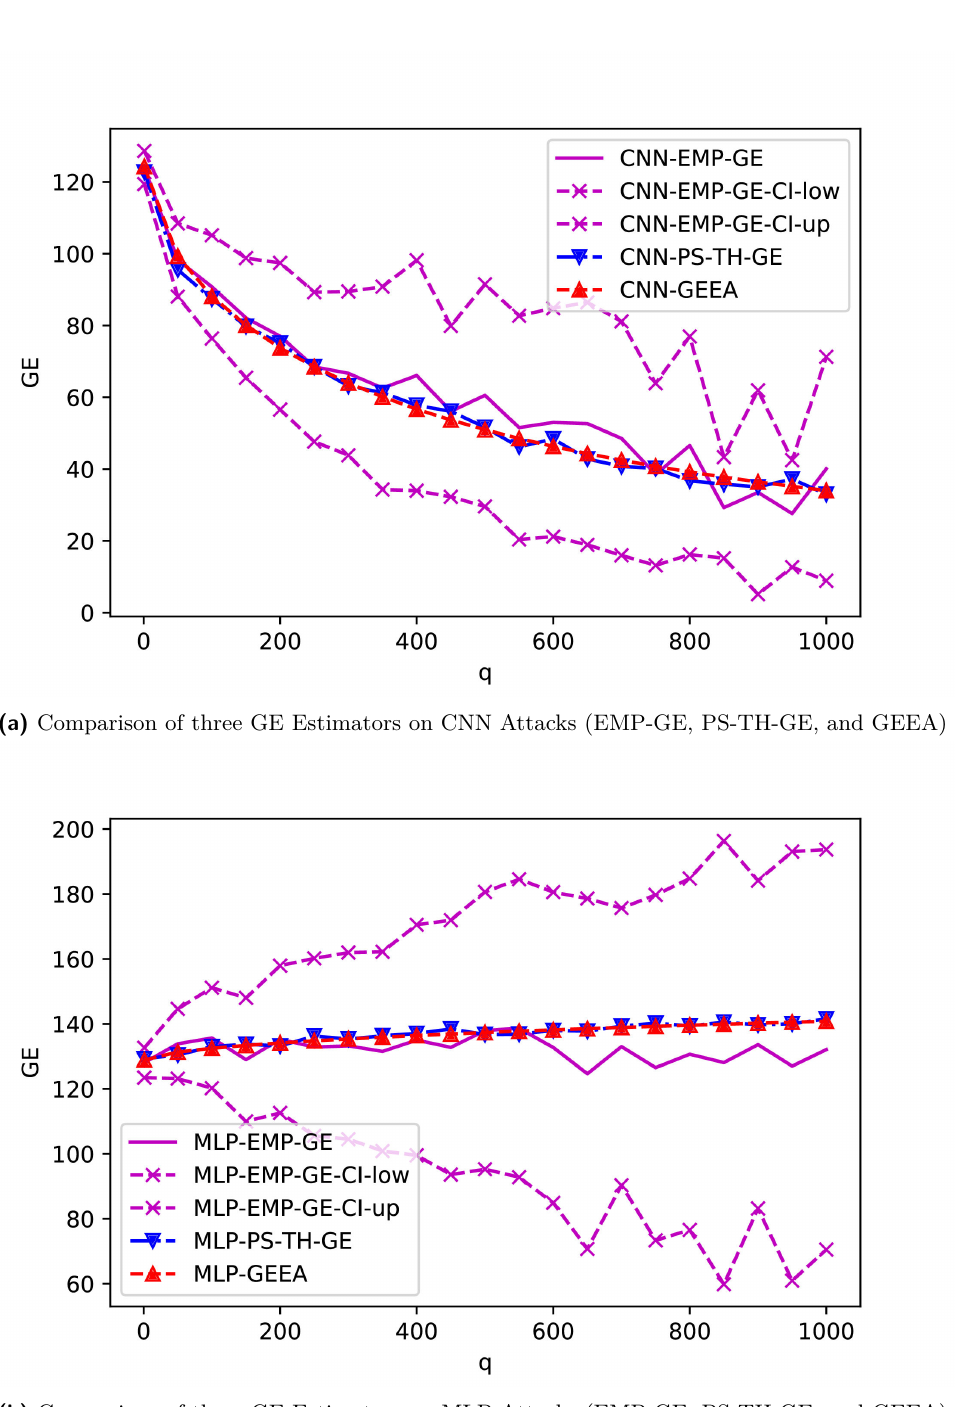
Figure 2: Comparison of One byte GE estimations on two types of DNN-SCA using ASCAD database. We also plot the 95% confidence intervals for EMP-GE, whose upper bound and lower bound are labeled respectively by EMP-GE-CI-up and